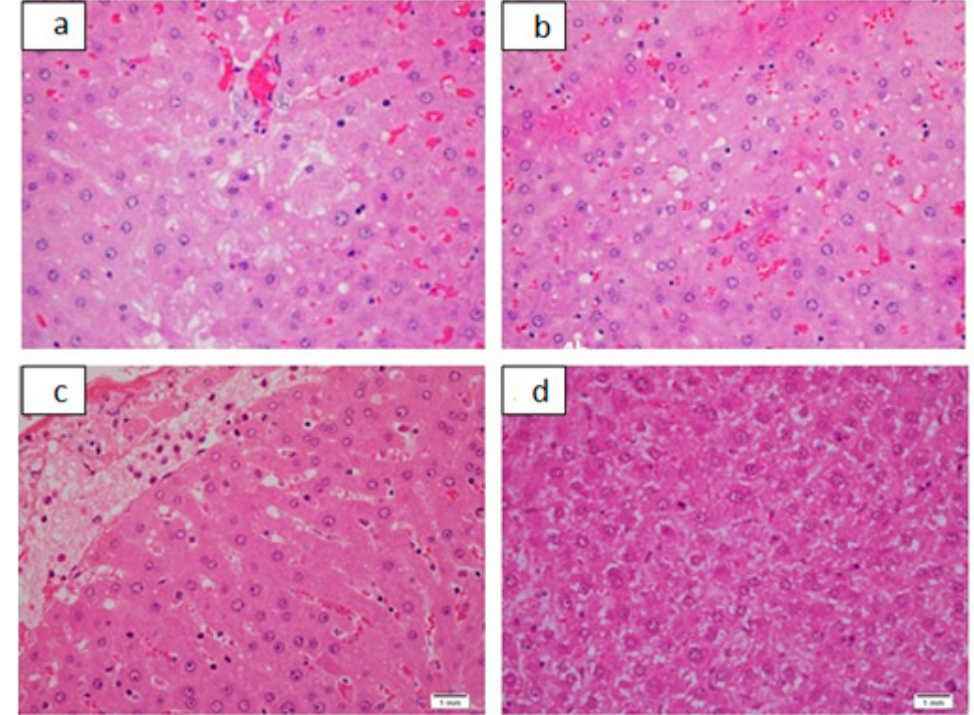
Figure 5. Hepatic histological alterations as seen in acute toxicity study. ( a ): Mixed hepatic micro and macrovesicular steatosis. An occasional apoptotic hepatocyte is also seen, H&E, ×40. ( b ): Mixed hepatic micro and macrovesicular steatosis, H&E, ×40. ( c ): Mild acute capsular inflammation, H&E, ×40. ( d ): Mild cytoplasmic vacuolization, H&E, ×40.